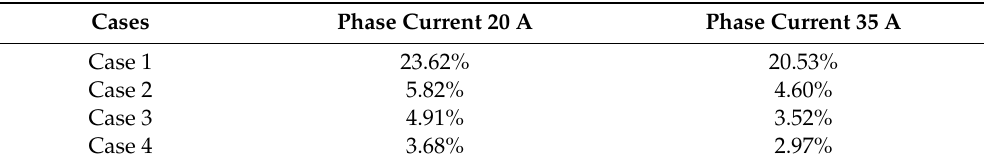
Table 3. Comparison of THDs under 500 rpm for four di ff erent cases.